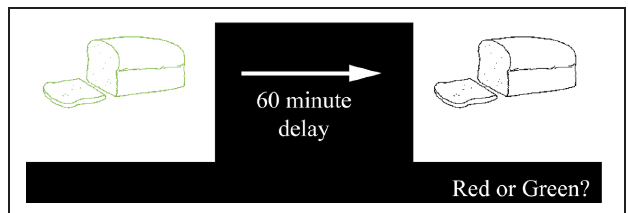
FIGURE 1 | Color picture association